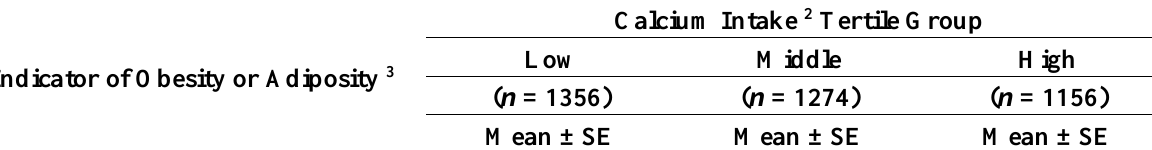
Table 5. Covariate-adjusted mean value of obesity or adiposity indicator by calcium intake 1